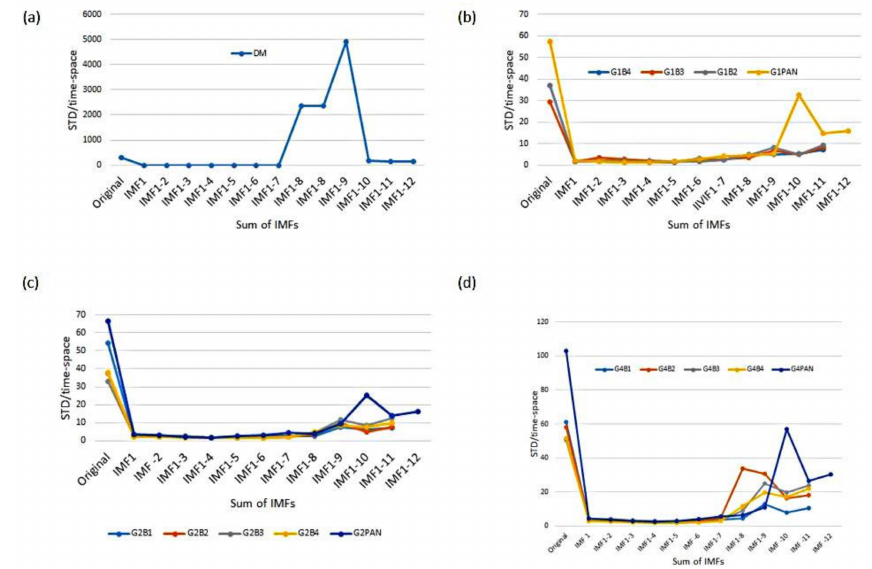
Figure 12. Same as Figure 11, but both temporal and spatial density calibrations are